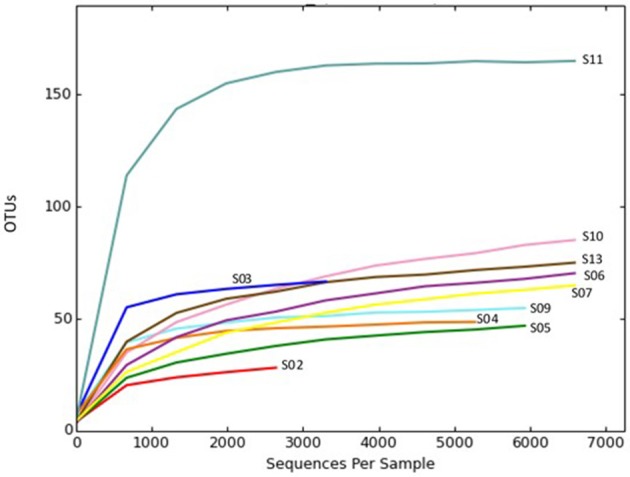
Rarefaction plot of OTU diversity in sponge samples collected from the Persian Gulf. Rarefaction curves were constructed at a 97% sequence similarity cut-off value by the QIIME package.